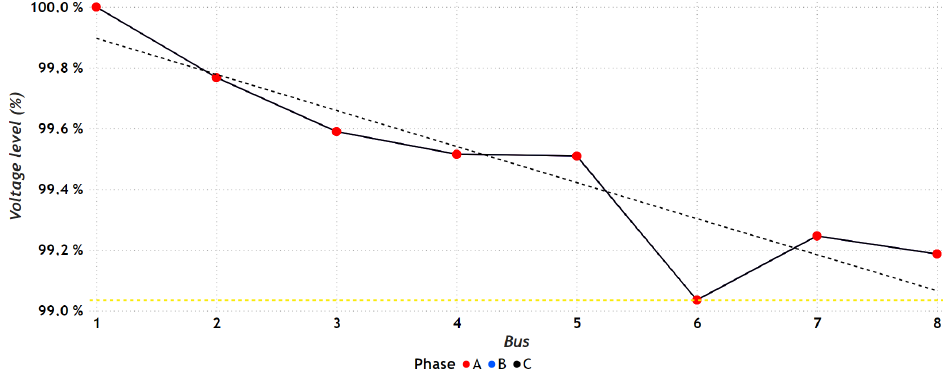
Figure 6. Behavior of the voltage profiles in the 8-bus three-phase distribution system under a balanced load scenario.